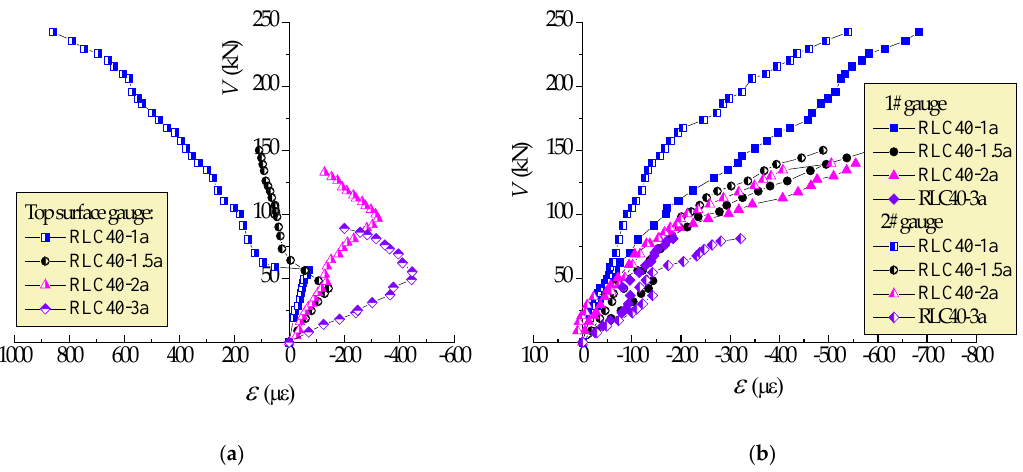
Figure 5. Concrete strain in shear-compression zone of test beams with different λ: ( a ) top surface gauge; ( b ) 1# and 2# gauges on side surface.